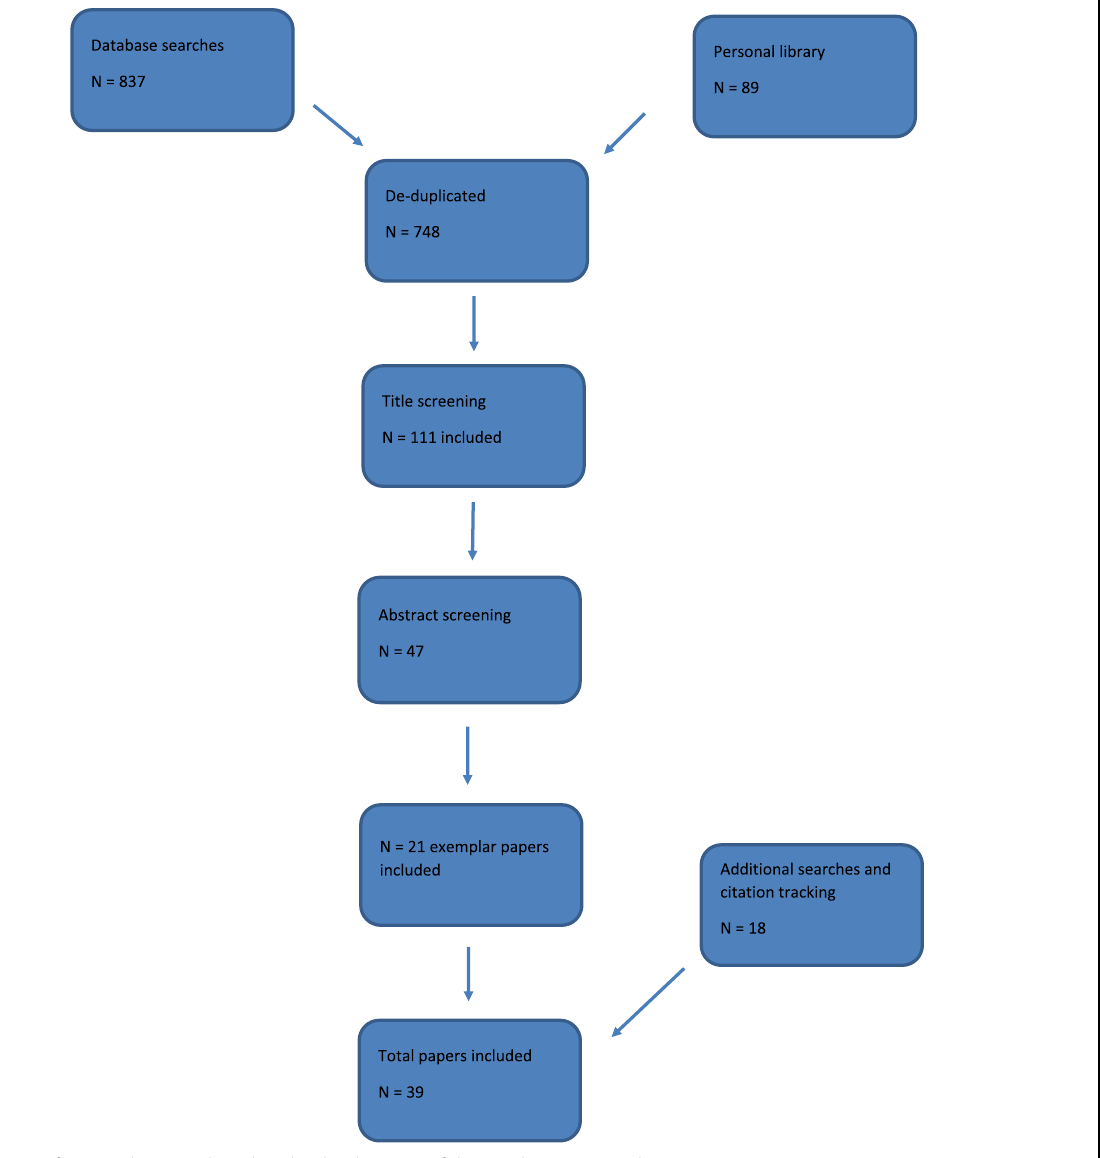
Fig. 1 Selection of papers that contributed to the development of the initial programme